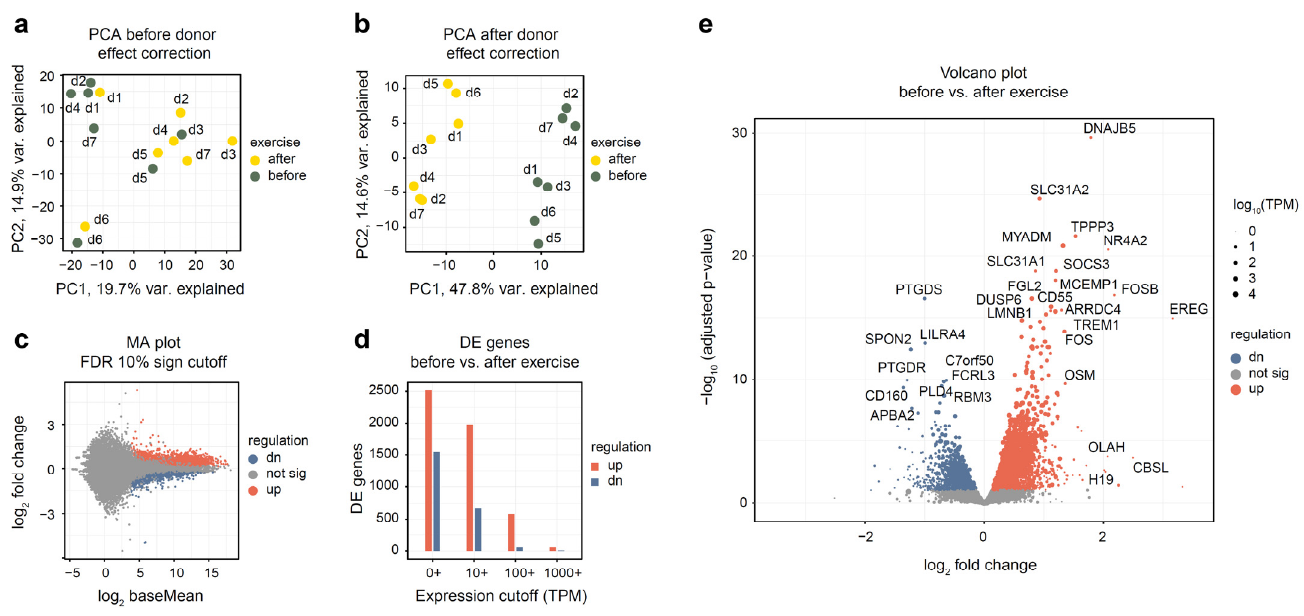
Figure 1. Overall assessment and differential expression analysis of whole blood RNA-seq from seven altitude-adapted female skaters before and after exercise. Differential expression analysis was performed using DESeq2 and “donor + exercise” design. Differentially expressed genes were reported at 10% FDR. “Up-regulated” indicates genes whose expression increased after the exercise. ( a , b ) PCA plot of the 14 studied samples, before and after donor-effect correction using comBat . Top 18,000 genes were used. Read counts were normalized using the rlog function from the DESeq2 package. ( c ) Log ratio—mean expression (MA) plot, with marked differentially expressed genes. ( d ) Number of differentially expressed genes depending on mean expression cutoff; TPM, transcripts per million. ( e ) Volcano plot of differentially expressed genes. Point size is scaled proportionally to mean gene